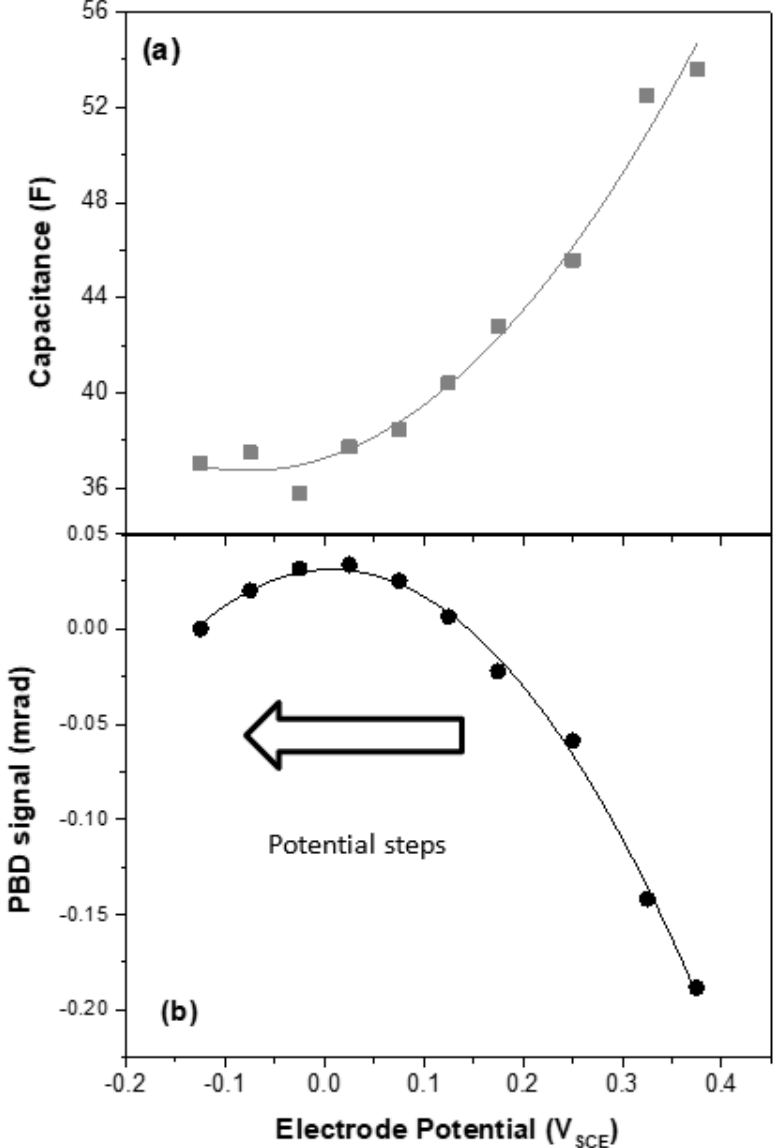
Figure 11. Simultaneous measurements of electrochemical capacitance ( a , gray squares ), measured by chronocoulometry, and ion population change ( b , black dots ), measured by chronodeflectometry, as a function of the potential. Electrode material = c(RF@F); in 1 M KNO 3 ; potential step = − 50 mV.